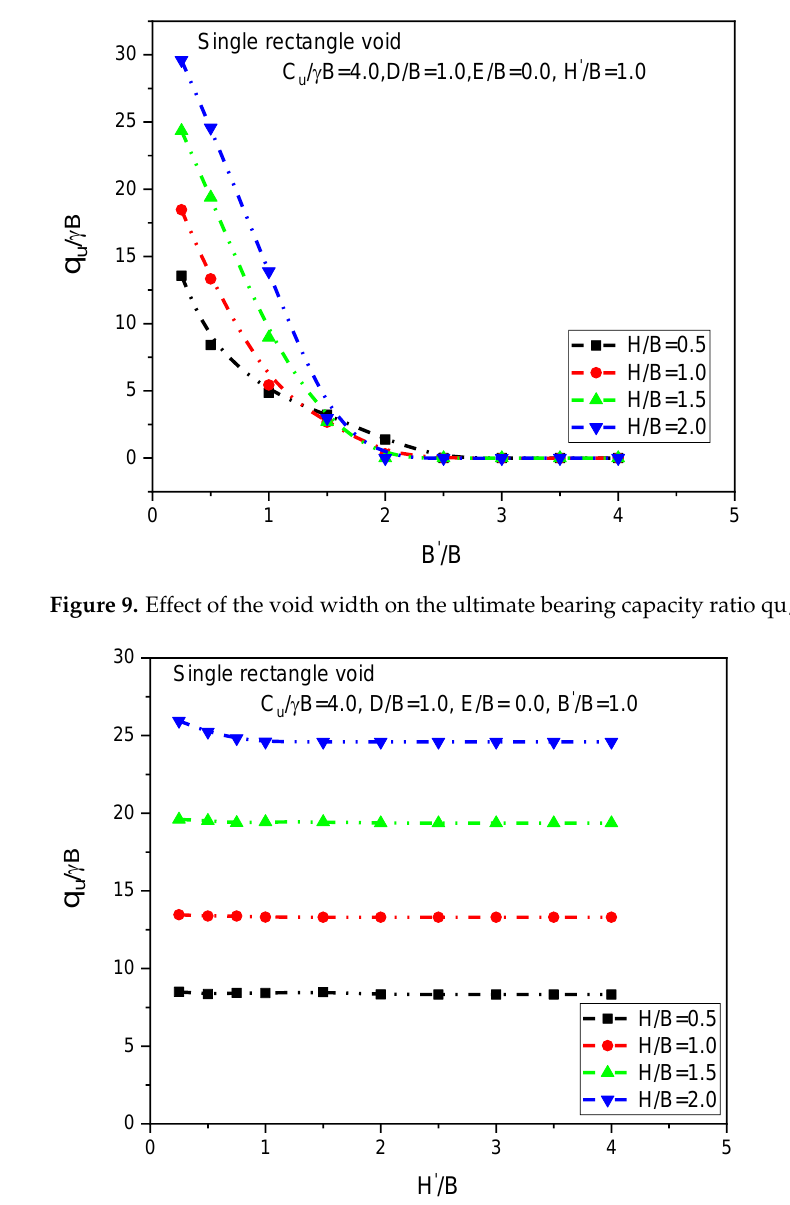
Figure 10. Effect of the void height on the ultimate bearing capacity ratio qu/γB.